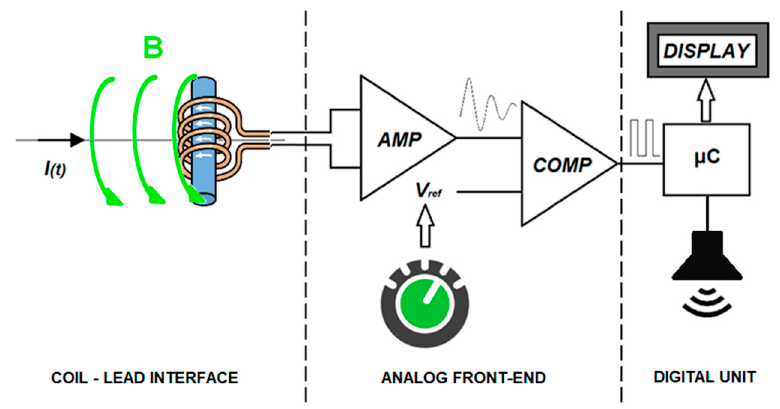
Figure 8. Schematic representation of the architecture proposed for the sensor.